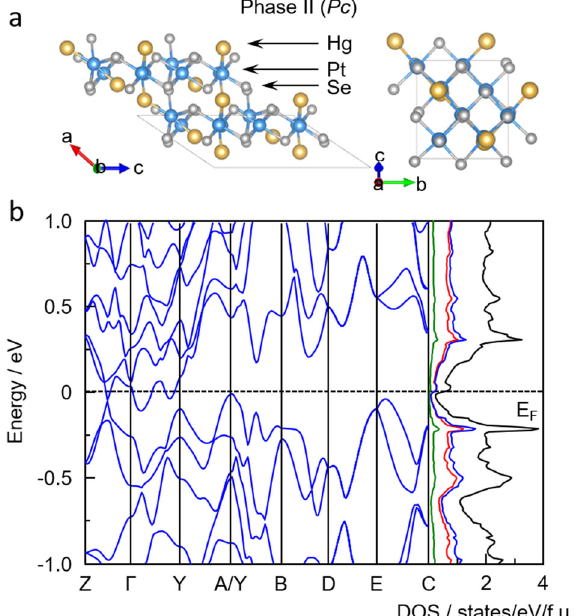
Fig. 4 Crystal and band structures of Pt 2 HgSe 3 in phase II. a Crystal structure of Pt 2 HgSe 3 in phase II ( Pc ). b Electronic band structure and density of states of Pt 2 HgSe 3 at 68 GPa without SOC. Black, blue, red, and olive lines stand for the DOS of whole, Pt, Se, and Hg,